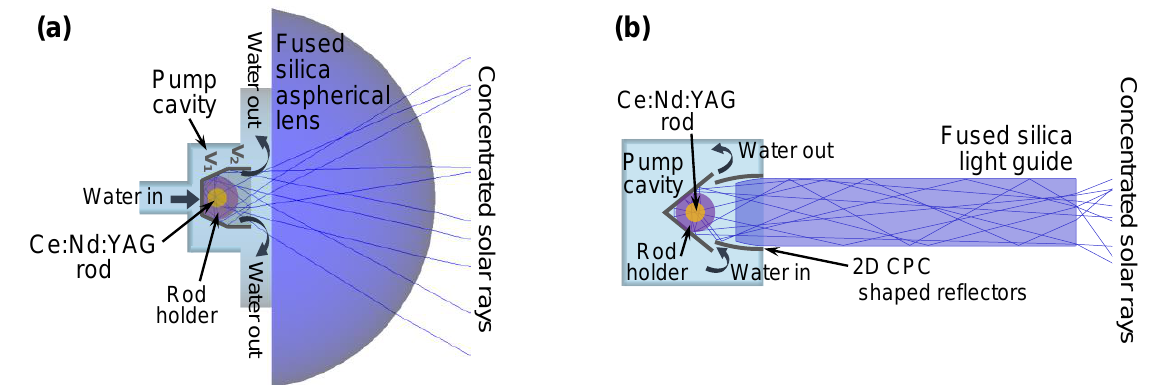
Figure 5. Schematics of the side-view of the solar laser heads with aspherical lens ( a ) and with light guide ( b ).